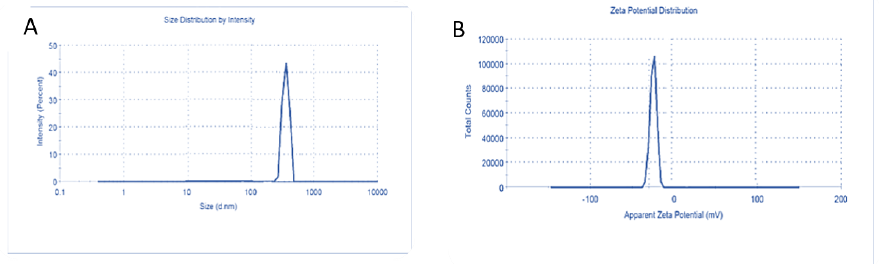
Figure 5. Characterization of CA-BSA-NPs: ( A ). Particle size distribution CA-BSA-NPs; ( B ). CA-BSA-NPs.zeta potential.